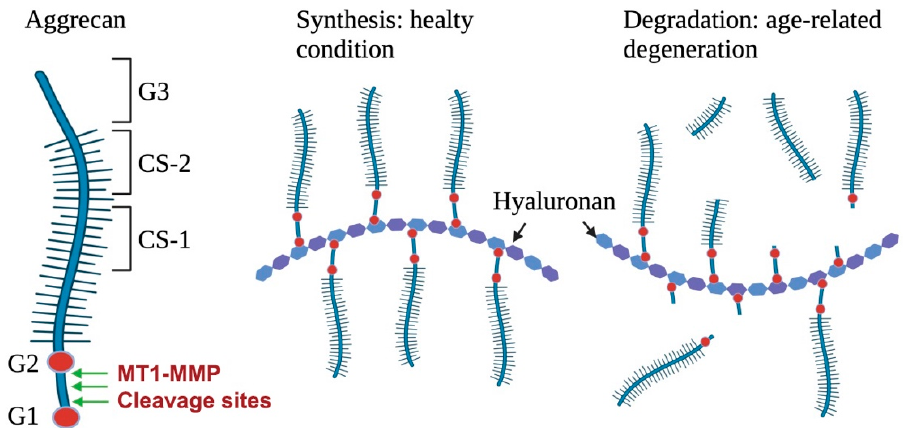
Figure 3. Structure of aggrecan and degradation. Aggrecan is a major proteoglycan in cartilage and plays an important role by forming a water-swollen matrix. MT1-MMP can cleave three positions between G1 and G2, which are essential binding motifs with the hyaluronan and link protein. MT1- MMP acts as an aggrecanase under pathophysiological conditions leading to the dehydration of articular cartilage.